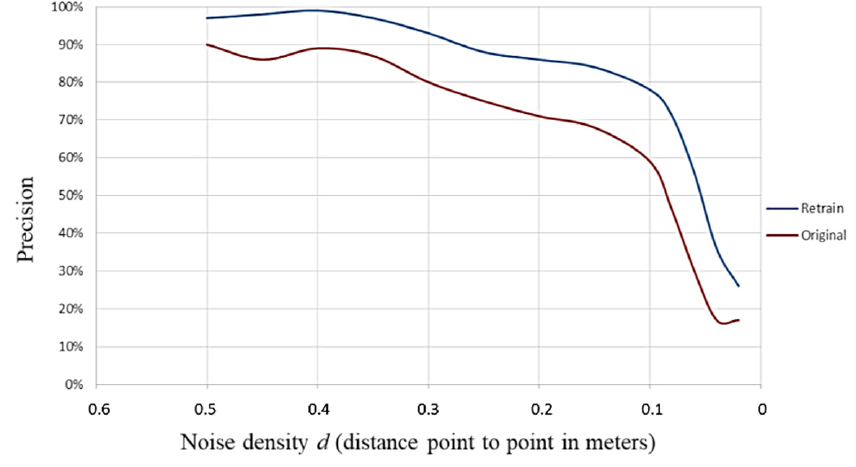
17 of 21 Figure 10. Comparison of precision of the re-trained and original CNN with point density varia-